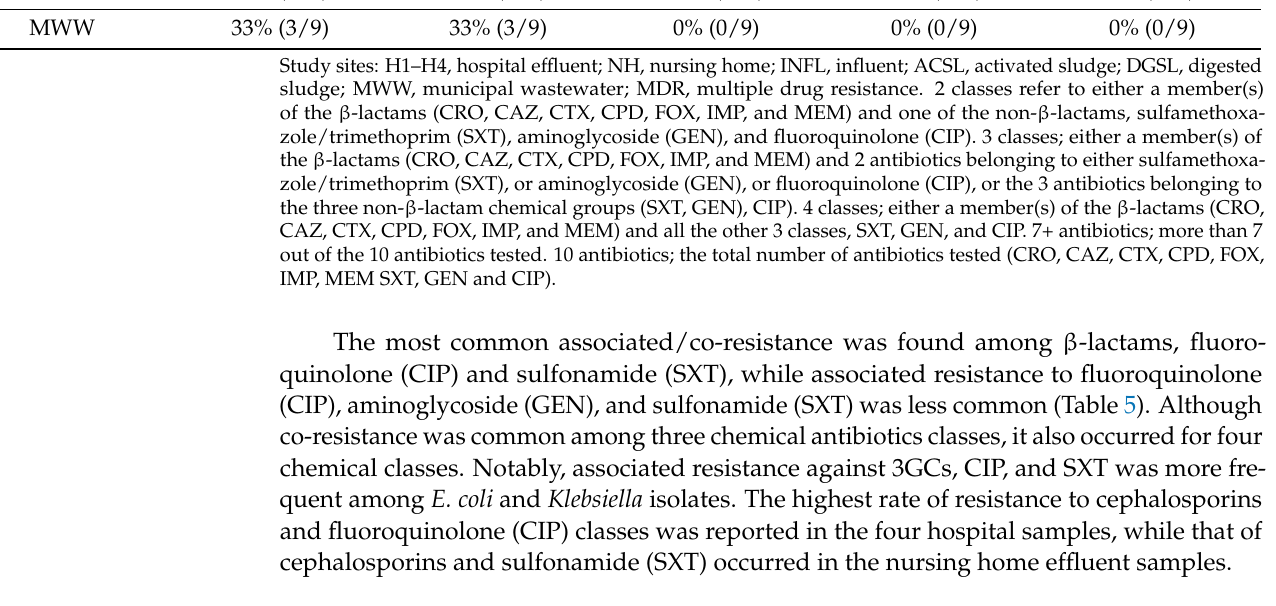
Table 5. The associated/co-resistance to the chemical classes of the antimicrobial agents ( n =